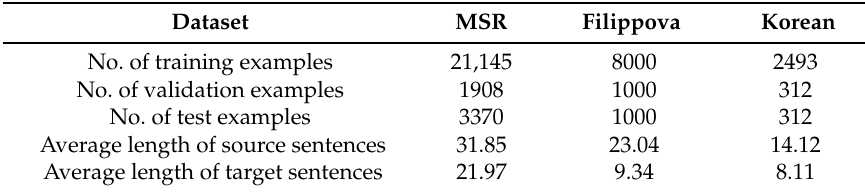
Table 2. Simple statistics on the datasets